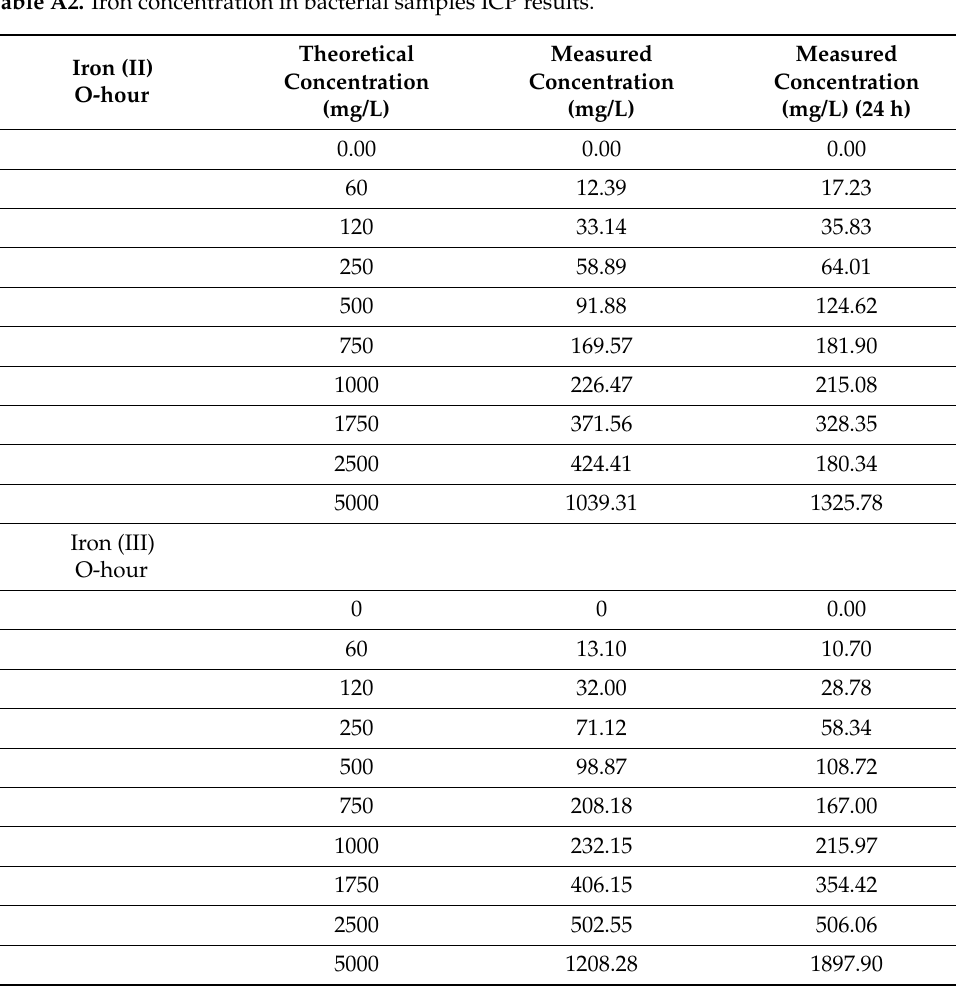
Table A2. Iron concentration in bacterial samples ICP